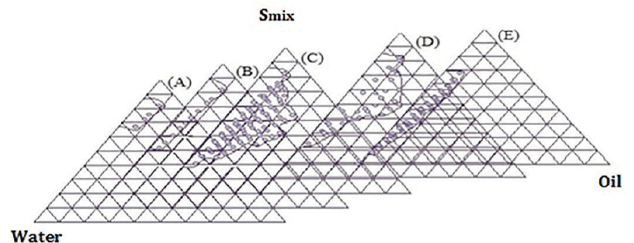
FIGURE 4 - Pseudo-ternary phase diagrams of Group II [S ratio = 1:0 (A), 1:1 (B), 2:1 (C), 3:1 (D), 4:1